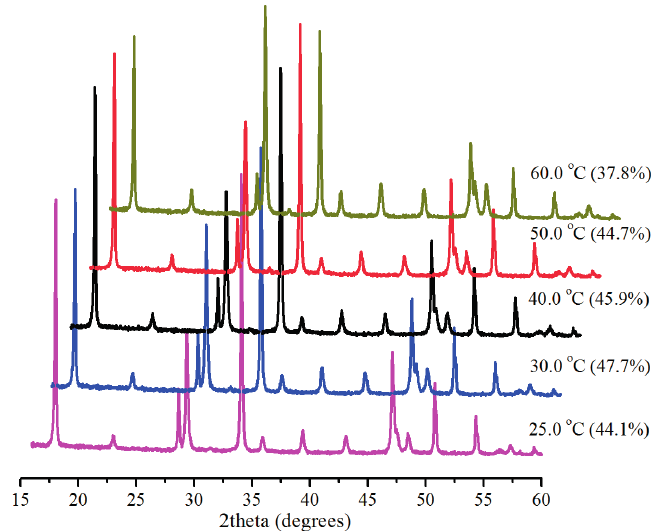
Figure 1. XRD (X-ray diffractometry) patterns and corresponding conversions (in brackets) for samples produced with 1-butyl-3-methylimidazolium bromide (Bmim[Br]) at various temperatures with 0.1 MPa in 5